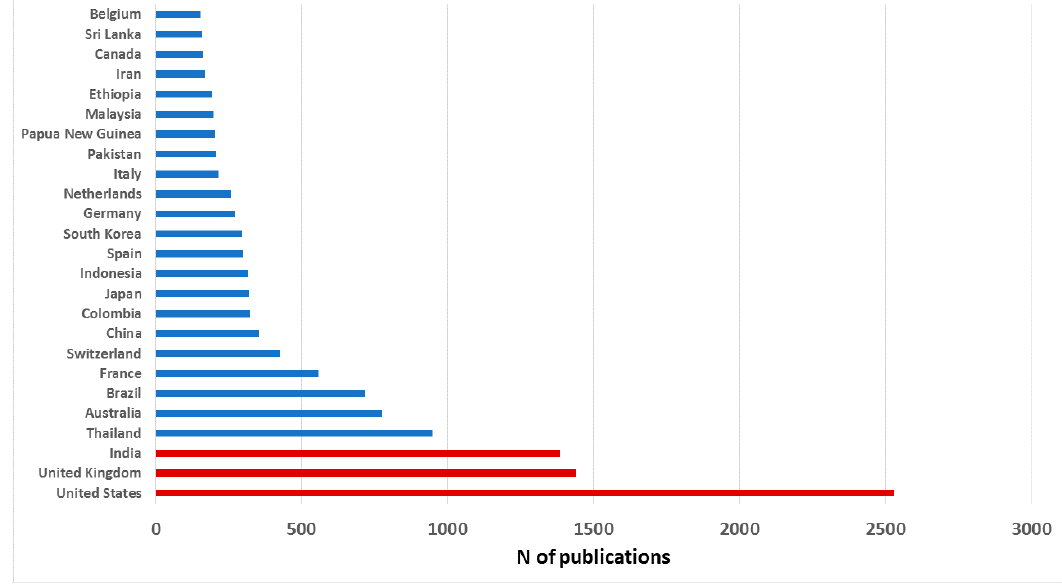
Figure 3. Representation of the countries with the highest number of publications on malaria and P. vivax.